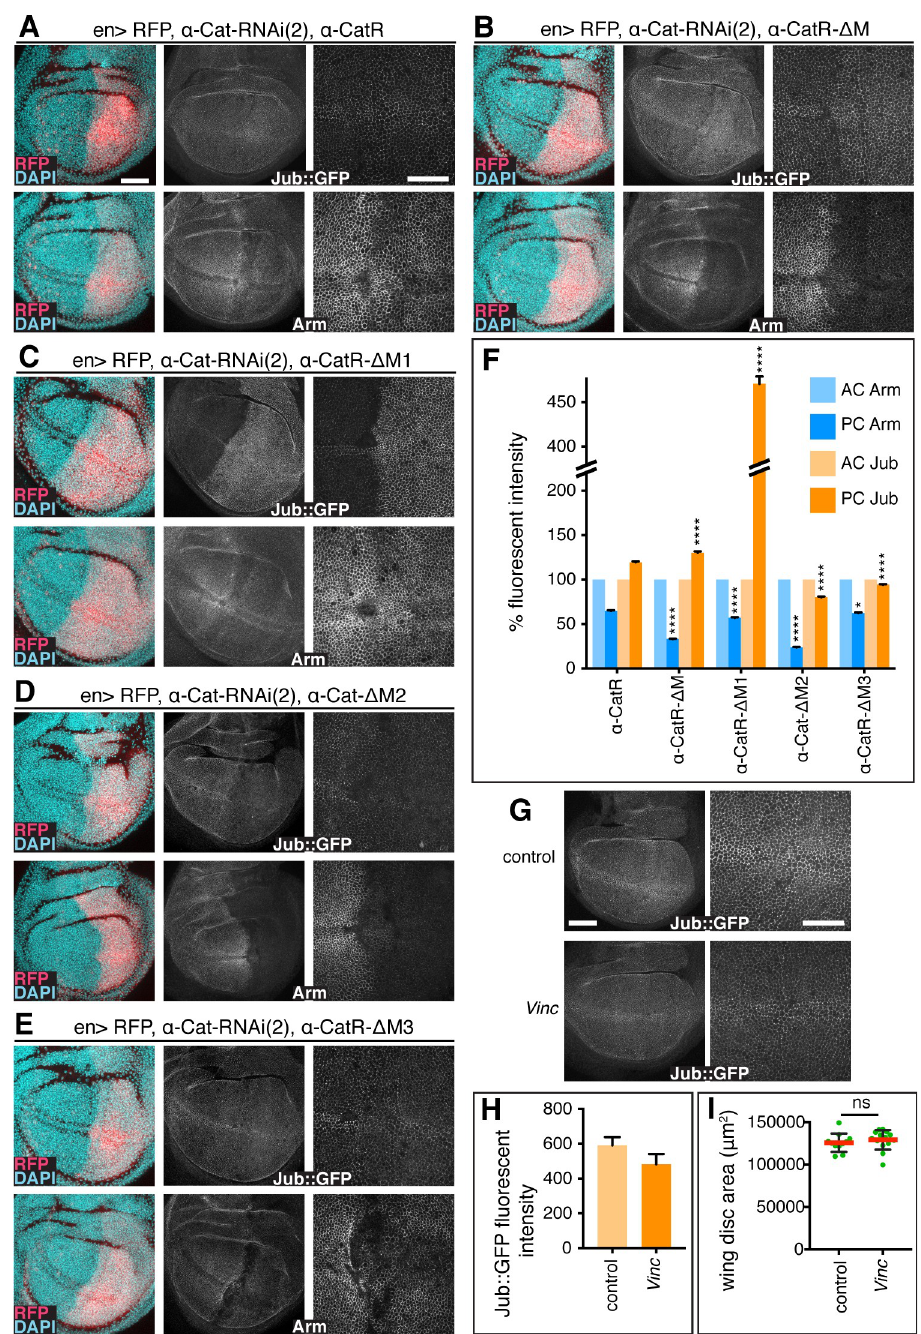
Fig 7. The M1 domain of α -Cat limits recruitment of Jub to AJs. (A-E) Late 3 rd larval instar discs expressing en- Gal4 , UAS-RFP , UAS- α -Cat-RNAi(2) and either UAS- α -CatR (A), UAS- α -Cat- Δ M (B), UAS- α -CatR- Δ M1 (C), UAS- α - Cat- Δ M2 (D), or UAS- α -CatR- Δ M3 (E). Discs express Jub::GFP controlled by its endogenous promoter (upper panels) and are stained for Arm (lower panels). Nuclei are labeled with DAPI. Close-up images to the right show wing pouch area on both sides of the anterior-posterior compartment boundary. Scale bars, 50 μ m and 25 μ m. (F) Comparison of relative fluorescent intensities between anterior compartment (AC) and posterior compartment (PC) for Jub::GFP (N = 500–1000 cells from five wing discs) and Arm (N = 500–1000 cells from four to six wing discs). AC values were normalized to 100%. Mann Whitney test was used to determine statistical significance comparing experimental and control ( α -CatR) discs. ���� (P � 0.0001), � (P = .0258). (G) Jub::GFP expression in control and Vinc null mutant ( Vinc 102 . 1 /Vinc 102 . 1 ) late 3 rd larval wing discs. (H) vinc null mutant and control late 3 rd larval wing discs have the